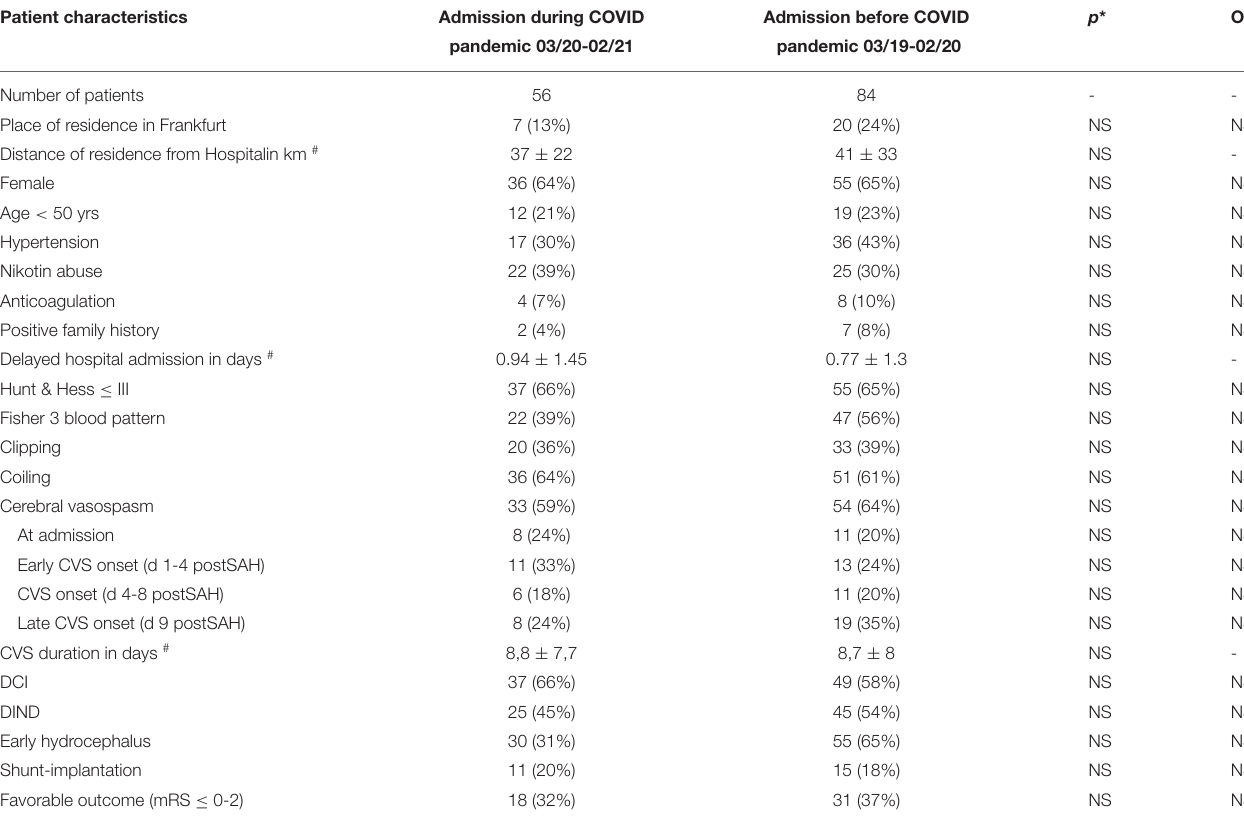
TABLE 1 | Characteristics of patients with aneurysmal subarachnoid hemorrhage (SAH) (aSAH) during 1 year of COVID-19 pandemic (03/20-02/21) vs. the pre-pandemic year (3/19-02/20) in Frankfurt am Main, Germany. Patient